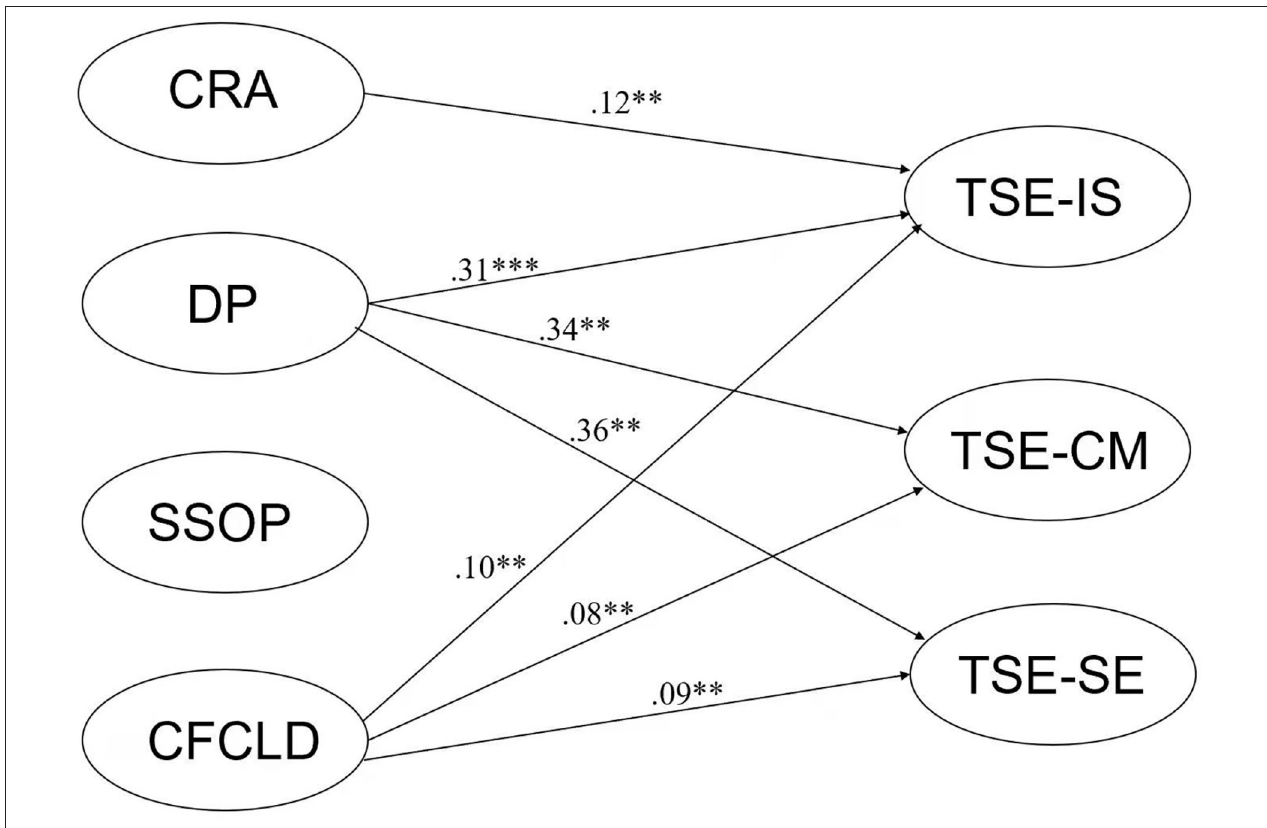
FIGURE 1 | SEM of CBPLC and TSE. *** p < 0.001, ** p < 0.01. TSE-IS, efficacy for instructional strategies; TSE-CM, efficacy for classroom management. TSE-SE, efficacy for student engagement; CRA, collaborative and reflective activity; DP, deprivatized practice; SSOP, shared sense of purpose; CFCLD, collective focus on children learning and